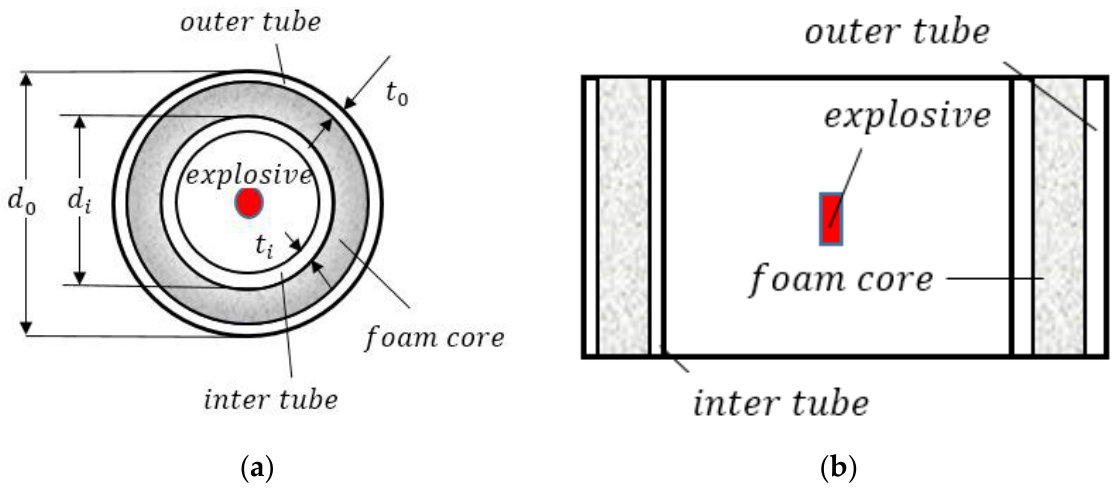
Figure 1. Schematic diagram of an aluminum foam sandwich tube. ( a ) Vertical view and ( b ) side view.